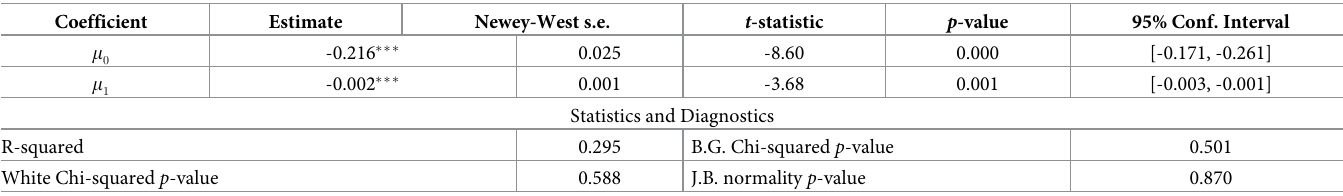
¼ μ þ μ þ u (Hypothesis S t � 0 1 j j j